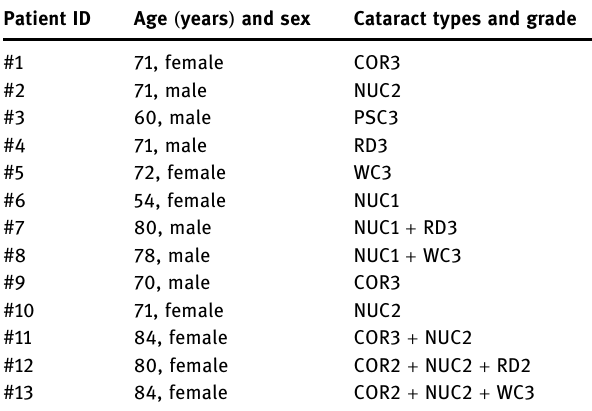
Table 1: Patient characteristics. COR, NUC, and PSC were graded using the WHO simpli fi ed cataract grading system, and RD and